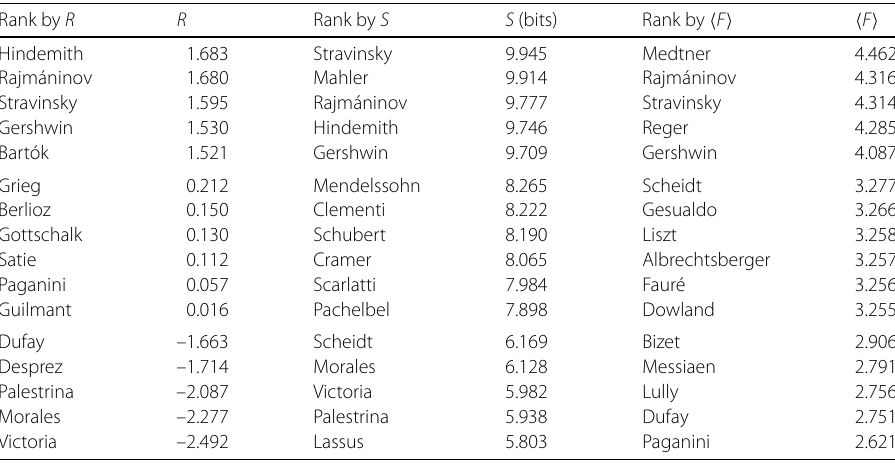
Table 4 Top-5, middle-6, and bottom-5 composers as ranked by relative richness R , entropy S , and average filling (cid:6) F (cid:7) Rank by R R Rank by S S (bits) Rank by (cid:6) F (cid:7) (cid:6) F (cid:7) Hindemith